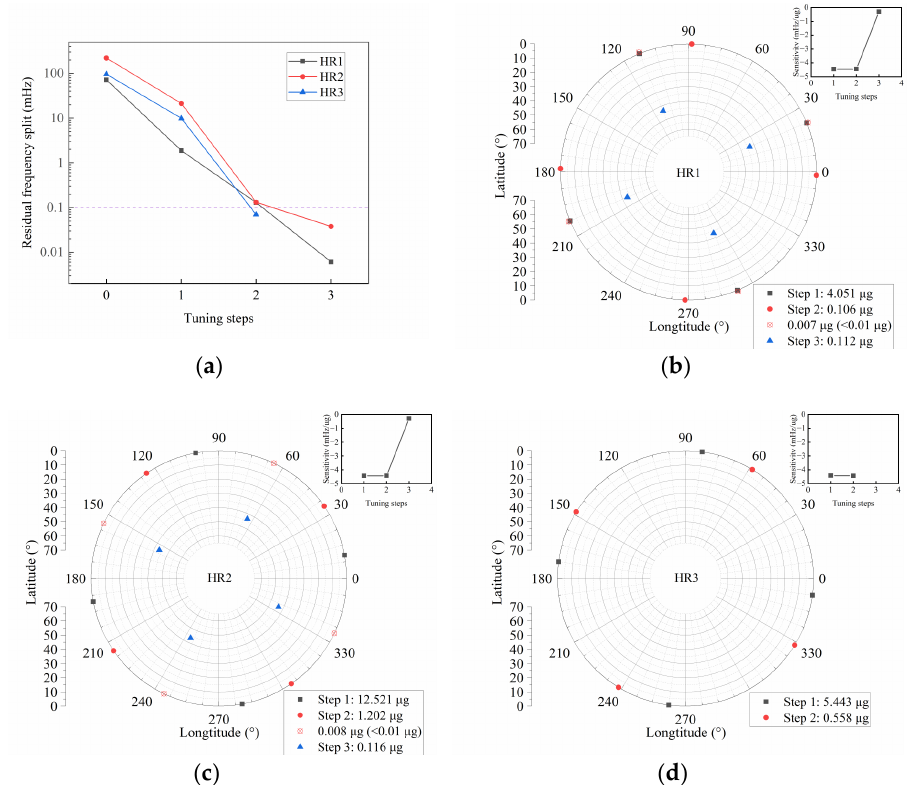
Figure 7. Modal tuning results of three HRs guided by proposed methodology. ( a ) The residual frequency split after modal tunings ( b – d ) demonstrate the tuning position, the amount of mass removal and sensitivity. Symbols with ‘ × ’ indicate that modal tuning cannot be implemented due to limited manufacturing capacity. In this case, it will be necessary to re-find the position of tuning on the surface with high latitude.